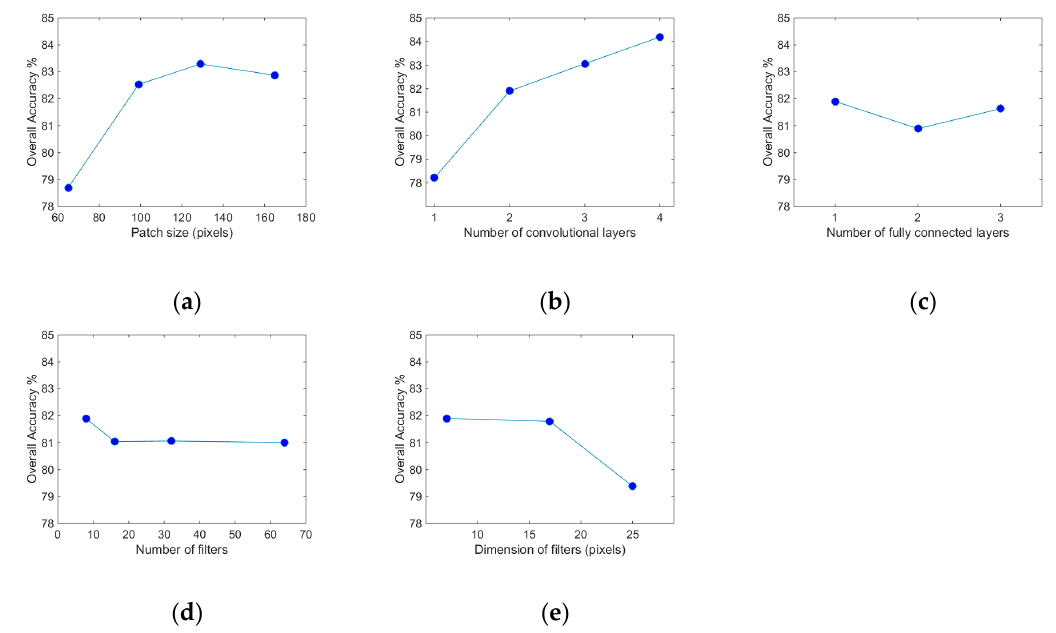
Figure 5. Results of the spatial feature learning hyperparameter optimization for ( a ) patch size, ( b ) convolutional layers, ( c ) fully connected layers, ( d ) number of kernels and ( e ) dimension of kernels.